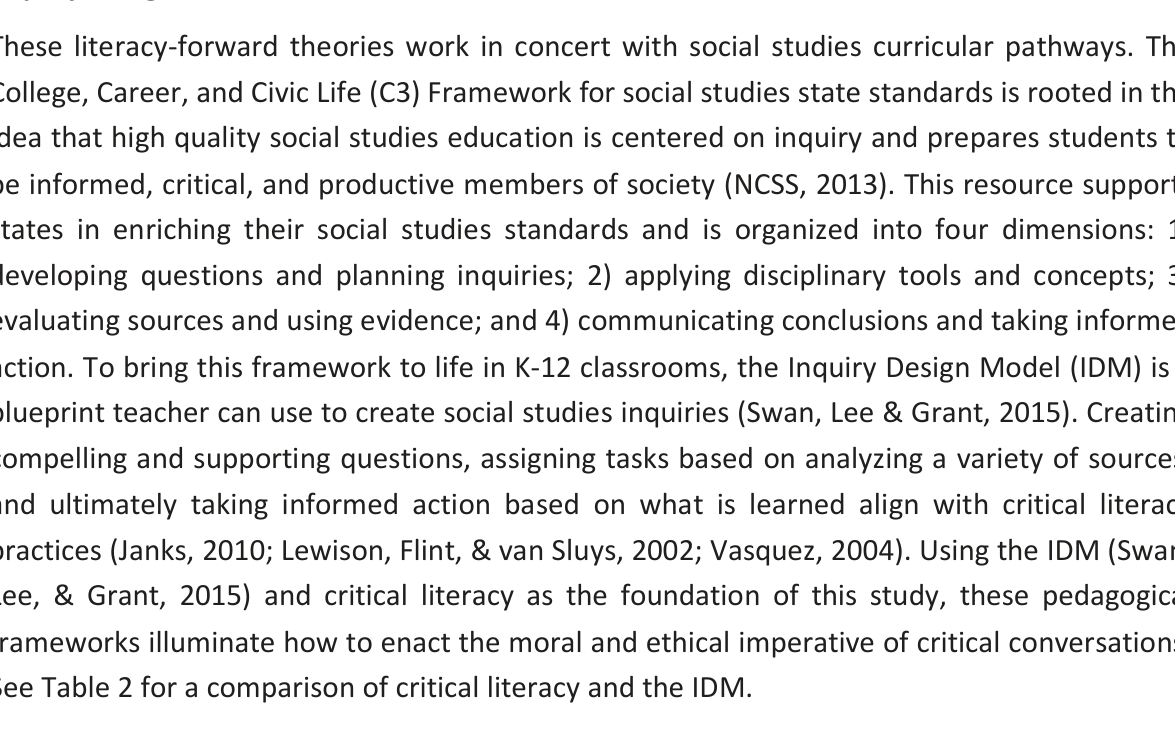
Table 2: A Comparison of Critical Literacy and the IDM Tenets of Critical